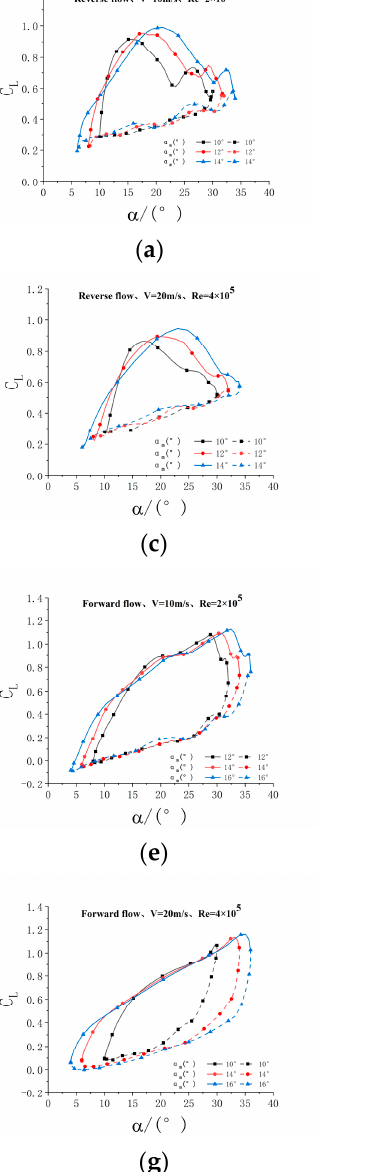
Table 9. Experimental conditions of varying pitch amplitude at different reduced frequencies.